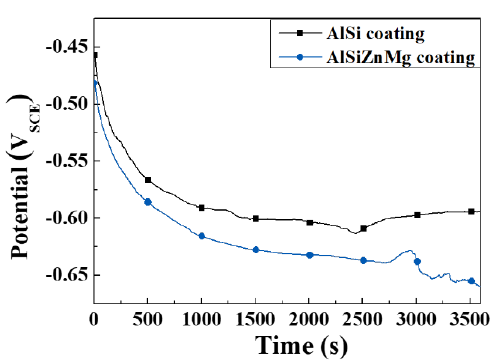
Figure 4. Open circuit potential (OCP) evolution measurement of AlSi-MC and AlSiZnMg-MC for 1 h in a 3.5% NaCl solution [20].